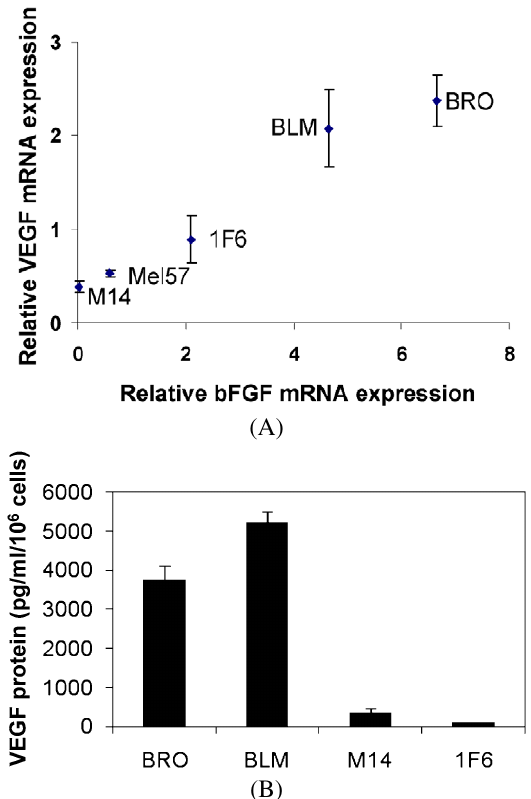
Fig. 8. bFGF and VEGF expression in a panel of human melanoma cell lines. (A) bFGF and VEGF mRNA levels of five different human melanoma cell lines: M14, Mel57, 1F6, BLM and BRO. mRNA ex- pression was determined by light-cycler RT-PCR and expressed as a ratio relative to β 2-microglobulin mRNA levels. (B) VEGF protein expression in conditioned medium was determined by ELISA. Bars represent mean values ± range of duplicate